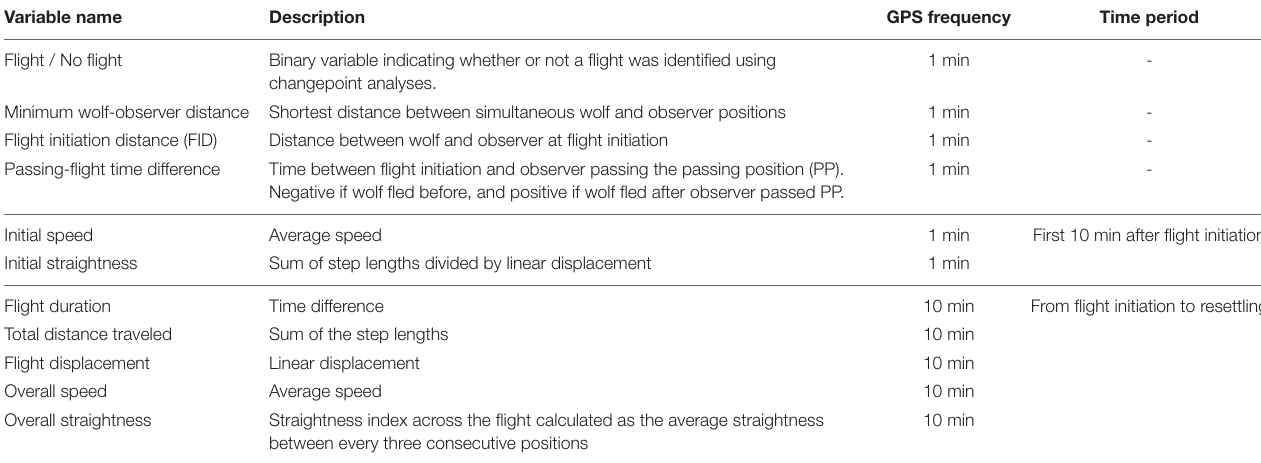
TABLE 1 | Description, temporal resolution and time period of the extracted variables used to describe the responses of wild wolves when approached by humans. Variable